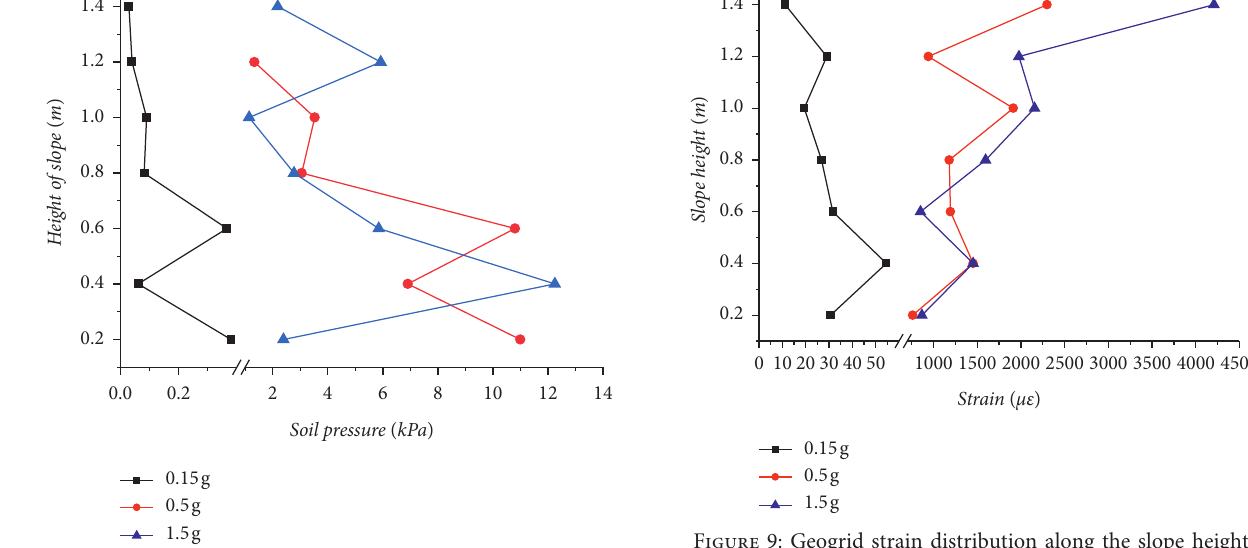
Figure 7: Distribution of earth pressure on the slope in the horizontal direction.